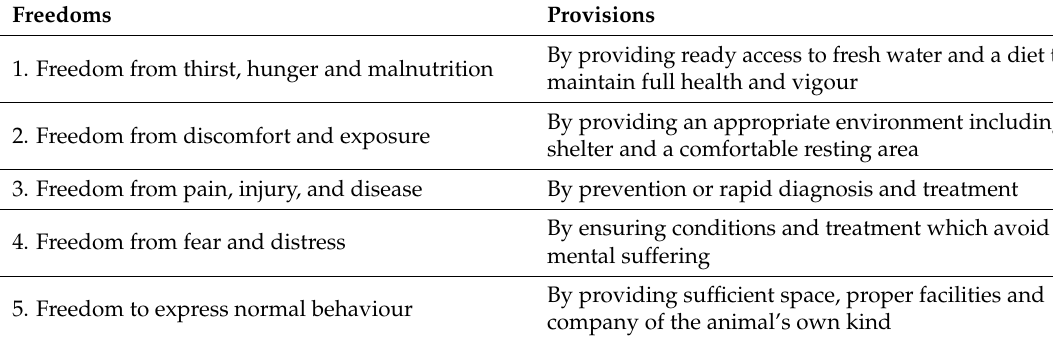
Table 1. The original Five Freedoms and Five Provisions for promoting farm animal welfare